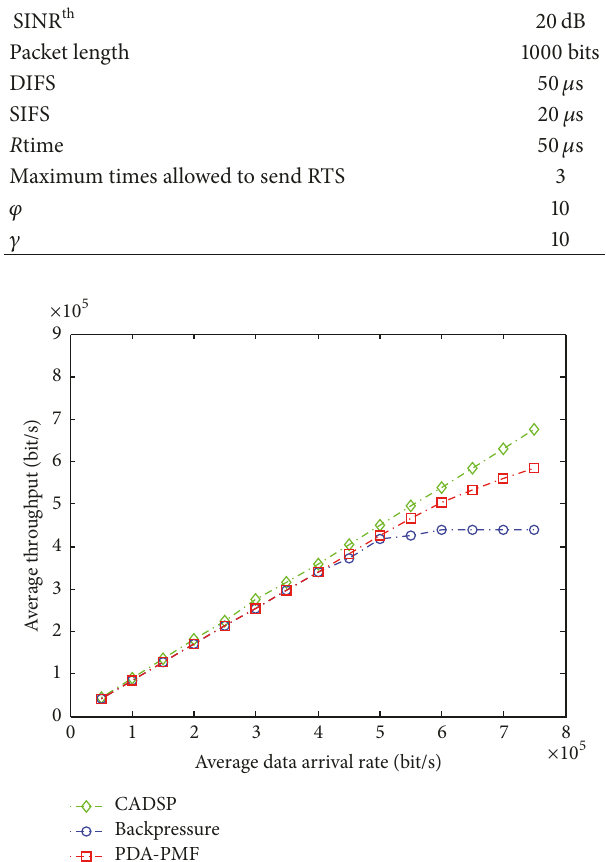
Figure 2: Comparison of average throughput of service 1 in multihop network.